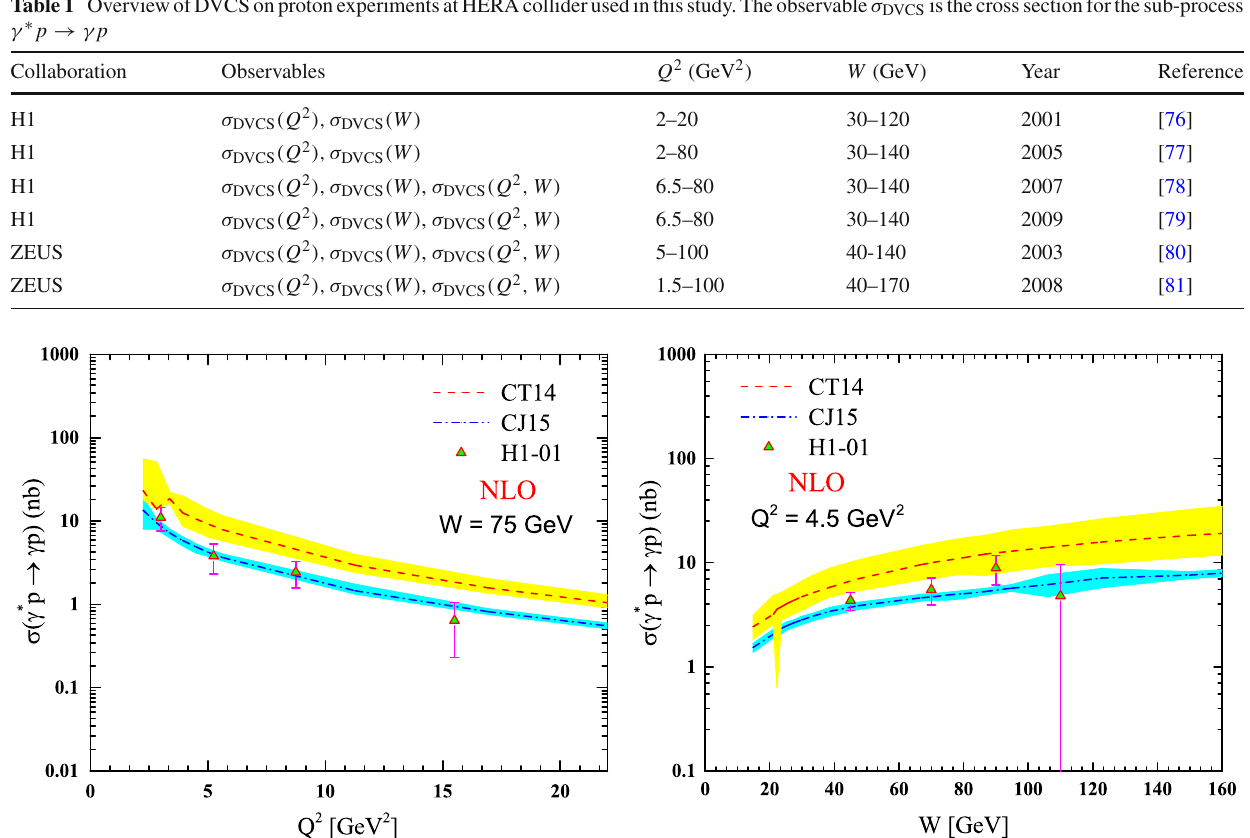
Fig. 4 The DVCS γ ∗ p → γ p cross section as a function of Q 2 (left) and W (right). The 2001 H1 data [76], where the statistical and system- atical errors are added in quadrature, is compared to our NLO pQCD